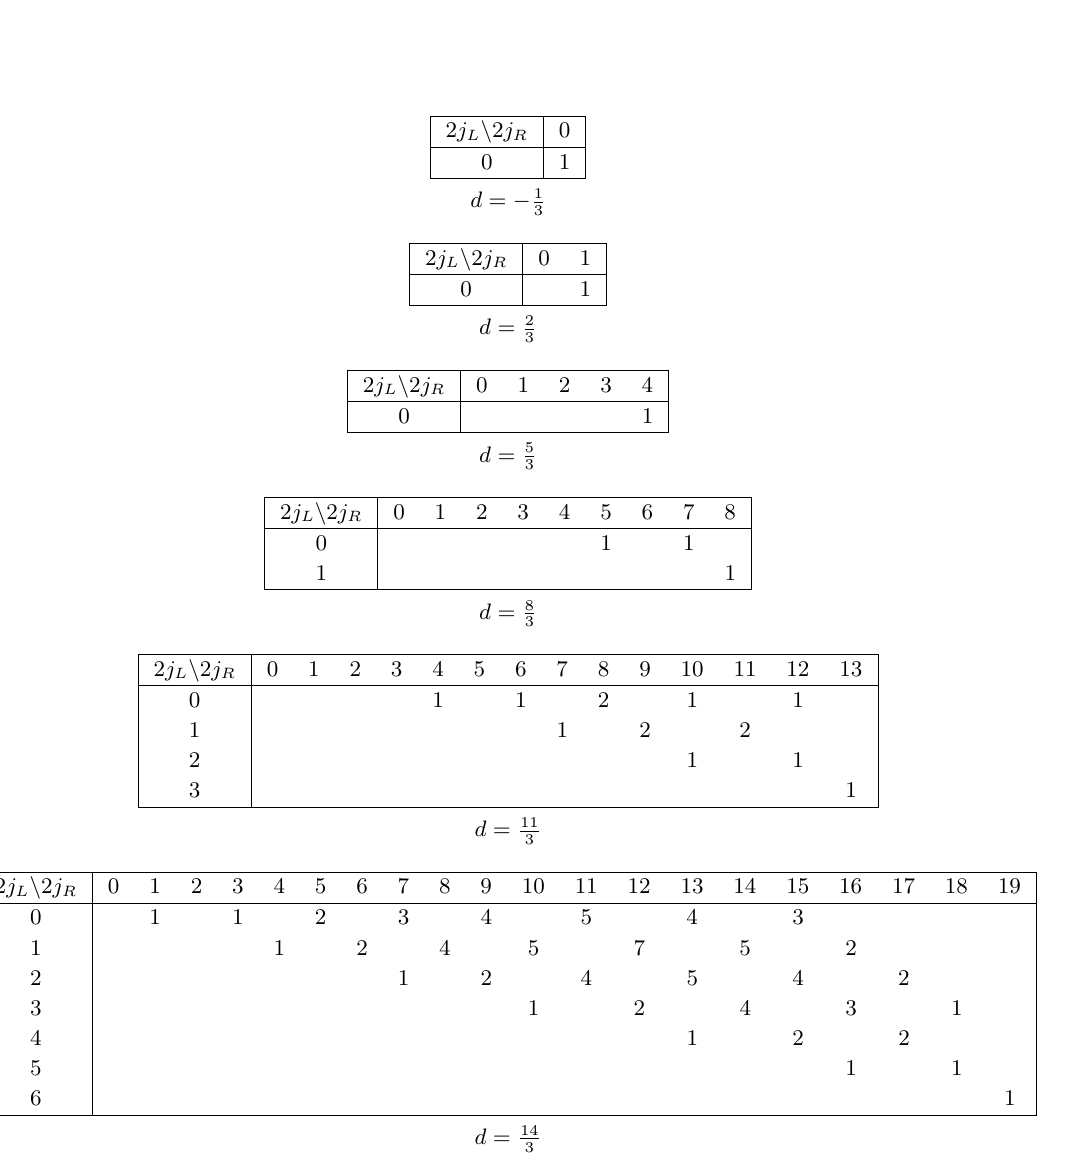
Table 15 . BPS spectrum of Wilson loop for local P 2 in the representation [ − 1] for the curve class dt